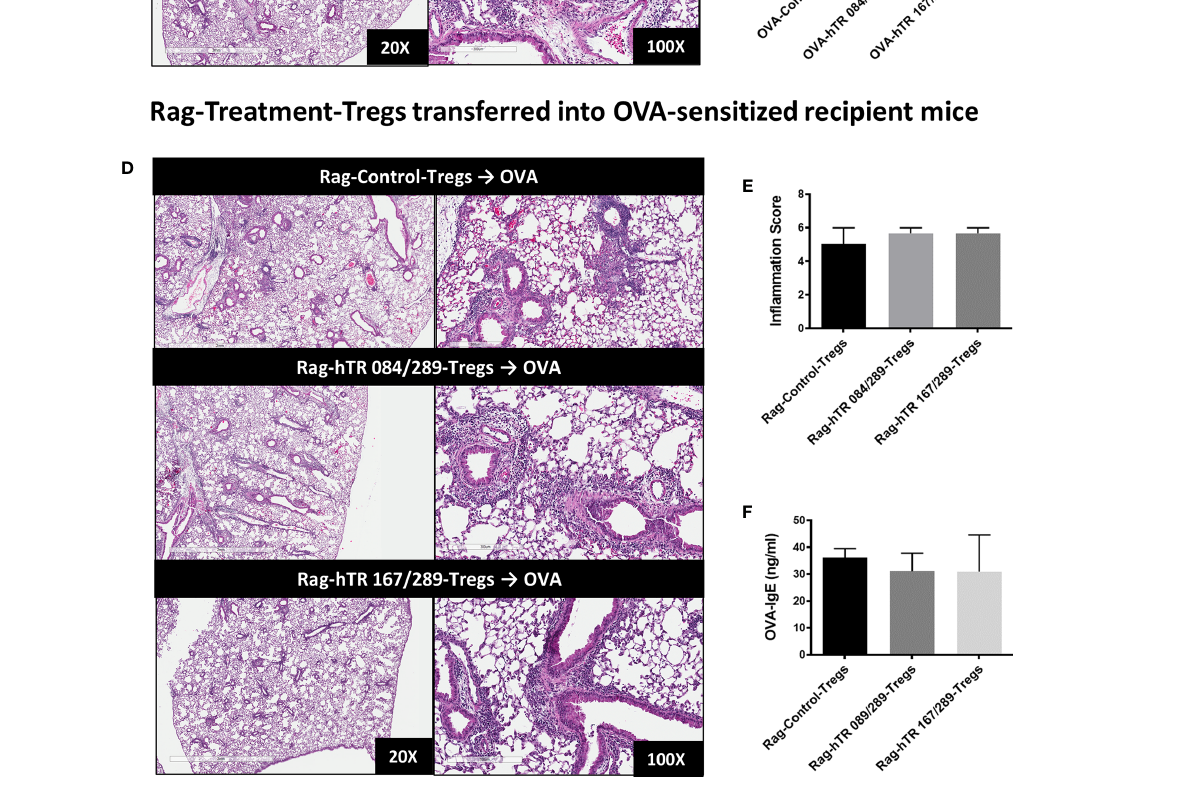
FIGURE 6 | Tregitopes induce antigen-speci fi c Tregs. (A) Please see schematic in Figure 5A . OVA sensitized mice were treated with 50,000 OVA-Control-Tregs, OVA-hTR ➋ , challenged with OVA, and lungs were harvested after 72 hours. H&E-stained lung sections were examined by microscopy 084/289-Tregs or OVA-hTR 167/289 -Tregs (20X, 100X) (B) and scored for in fl ammation by two independent observers. (C) OVA-speci fi c plasma IgE levels were signi fi cantly diminished in OVA-Treg transferred mice. ➌ (D) OVA sensitized mice were treated with 50,000 Rag-Control-Tregs, Rag-hTR 084/289-Tregs or Rag-hTR 167/289 -Tregs , challenged with OVA, and lungs were harvested after 72 hours. H&E stained lung sections were examined by microscopy (20X, 100X) (E) and scored for in fl ammation by two independent observers. (F) In contrast to panel (C) , OVA-speci fi c plasma IgE levels were not diminished in Rag-Treg transferred mice. Representative of 2 independent experiments, n = 3-4 **p, 0.01, one-way